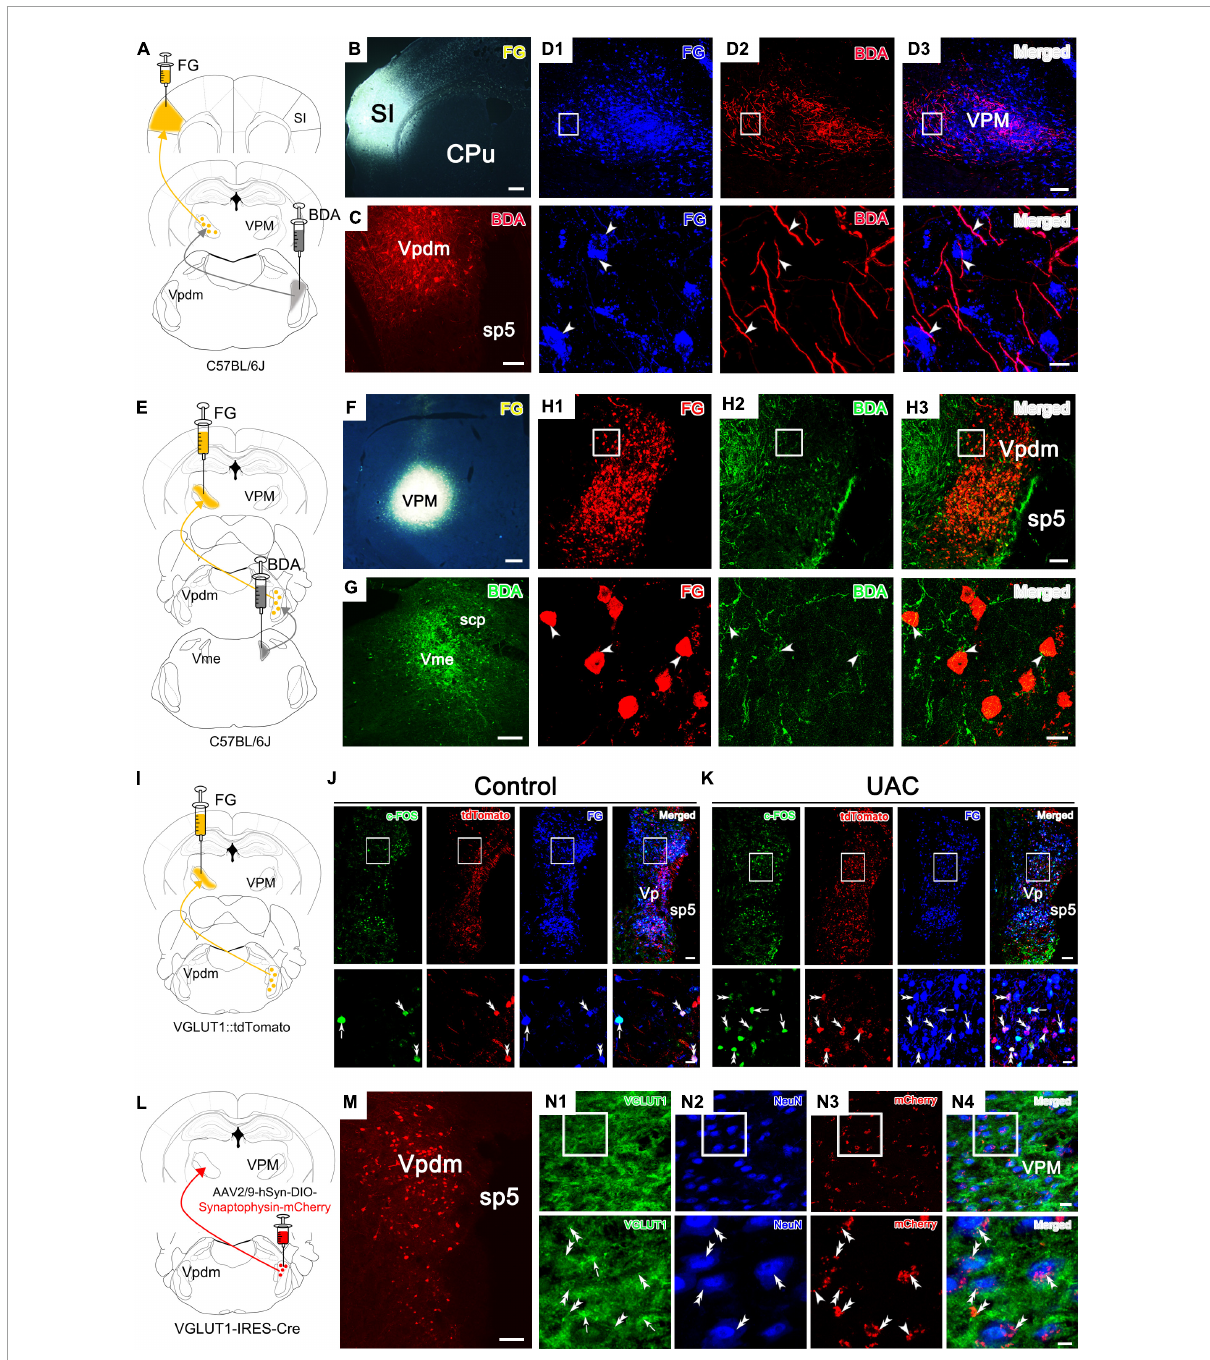
FIGURE4 Tracing experiments with the Vpdm VGLUT1 -VPM, Vpdm-VPM-SI and Vme-Vpdm-VPM pathways. (A) Schematic diagram of the Vpdm-VPM-SI neural pathway, demonstrating that FG was injected into the SI and BDA was injected into the Vpdm. (B,C) Representative coronal section showing the FG injection site in the SI and the BDA injection site in the Vpdm. Scale bar: 200 µ m. (D) (Top) Immunofluorescence histochemical staining showing FG/BDA double-labeled neurons and terminals in the VPM. Scale bar: 100 µ m. (Bottom) The enlarged VPM in the white square in D1-D3, showing that BDA-labeled nerve axons pass close to FG-retrograde-labeled neurons (arrowheads). Scale bar: 20 µ m. (E) Schematic diagram of the Vme-Vpdm-VPM neural pathway, verifying that FG was injected into the VPM and BDA was injected into the Vme. (F,G) The FG injection site in the VPM and the BDA injection site in the Vme. Scale bar: 200 µ m. (H) (Top) Immunofluorescence histochemical staining showing FG/BDA double-labeled neurons and terminals in the Vpdm. Scale bar: 100 µ m. (Bottom) The enlarged Vpdm in the white square in H1–H3, showing that BDA-labeled axon terminals were close to FG-retrograde-labeled neuronal cell bodies (arrowheads). Scale bar:20 µ m. (I) SchematicdiagramoftheVpdm-VPMpathway,demonstratingFGinjectionintotheVPMofVGLUT1:tdTomatomice. (J,K)